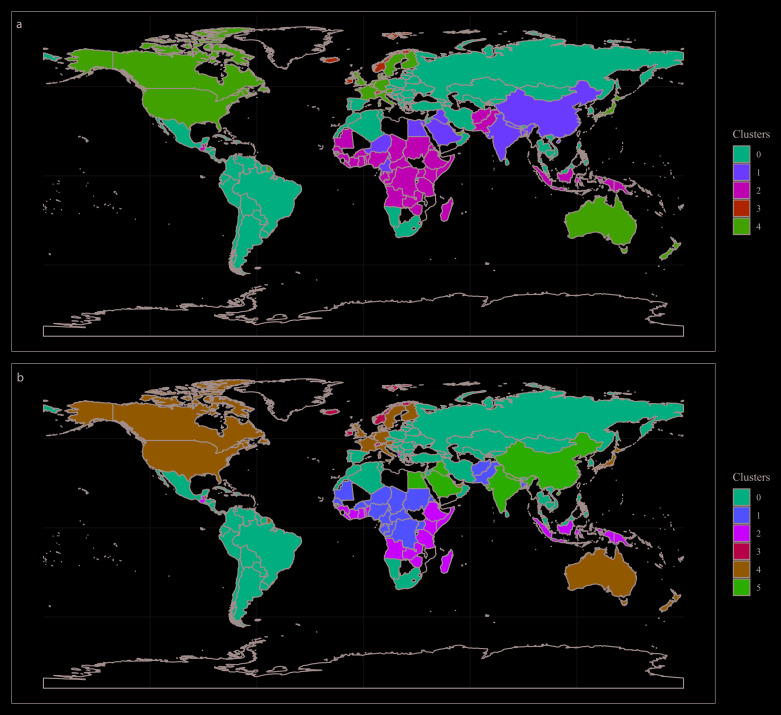
World map showing countries coloured as per the model with five (
A) and six (
B) clusters.